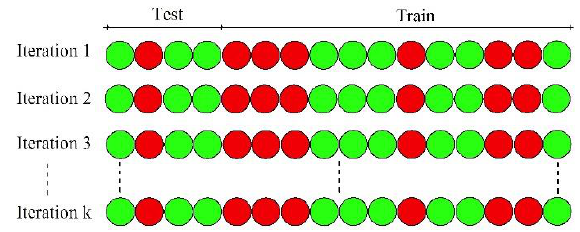
Figure 3. Schematic layout of the k-fold cross-validation.